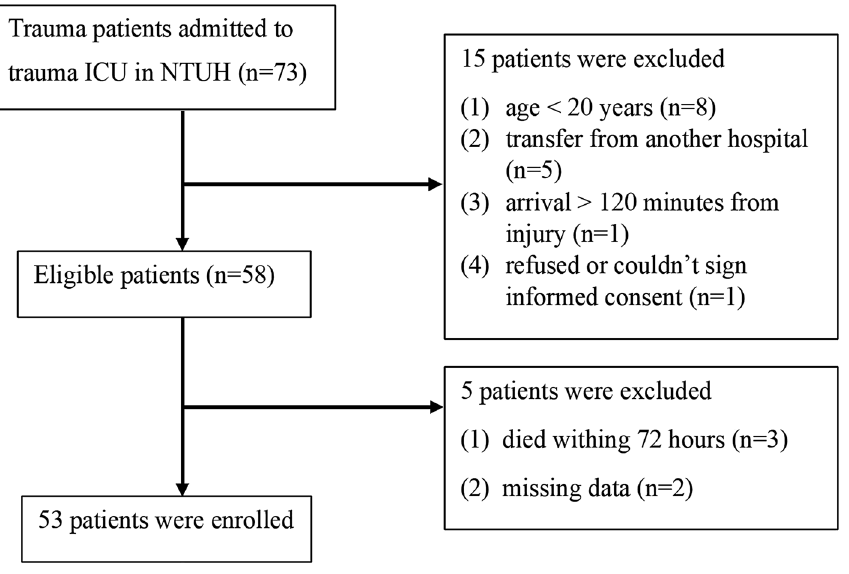
Figure 1. Patients’ recruitment